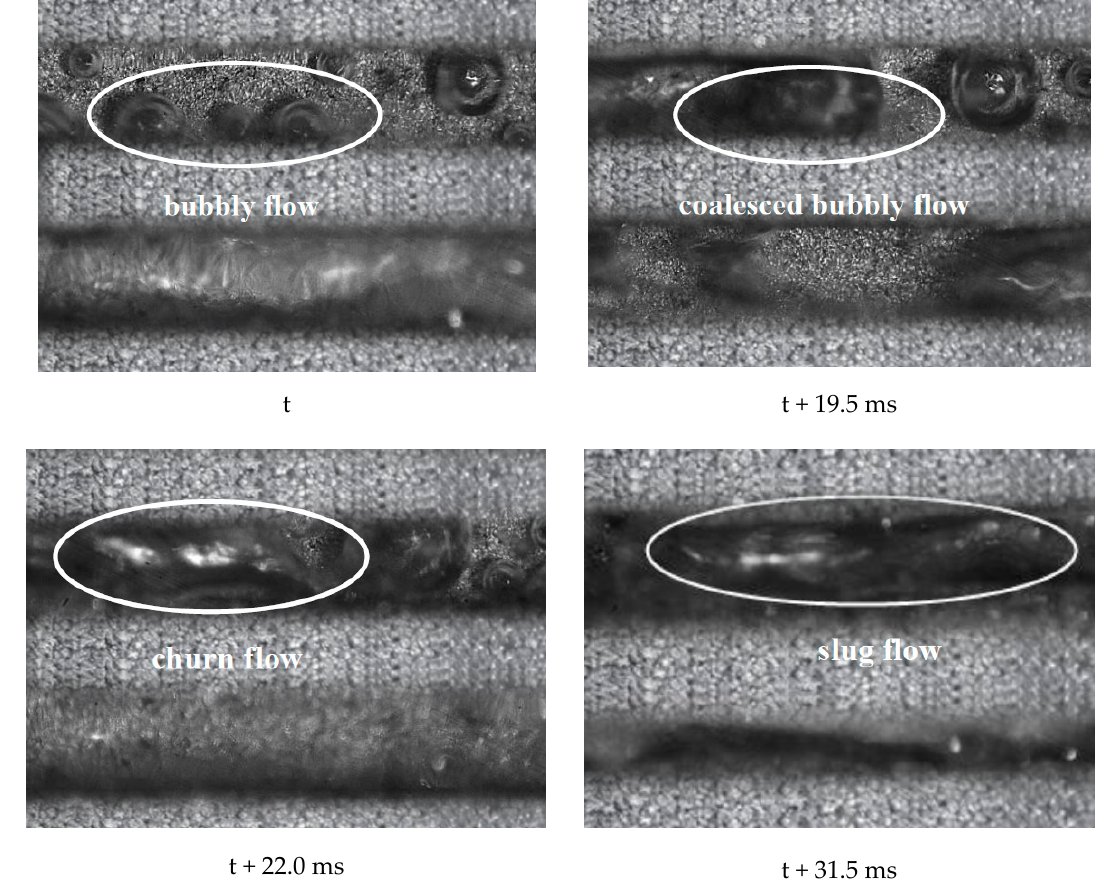
Figure 6. Flow pattern transition in the porous microchannel at q = 55 W/cm 2 , G = 71 kg/m 2 ·s and T in = 60 °C.